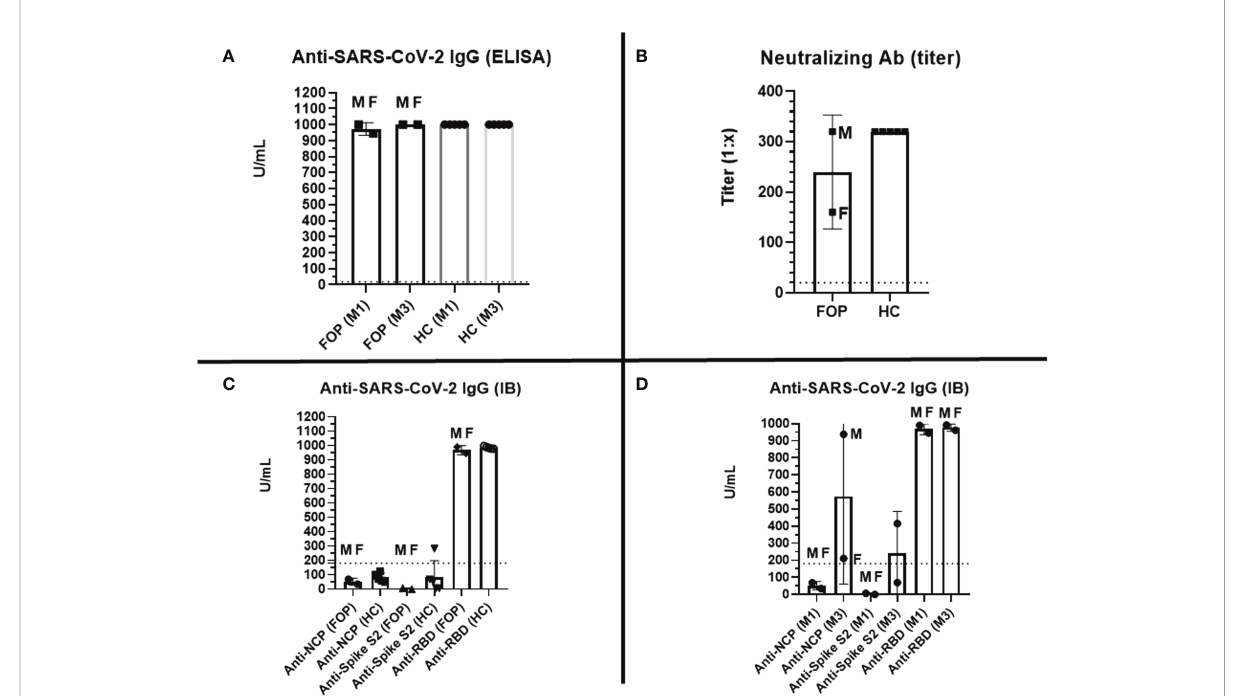
FIGURE 2 Speci fi c post-vaccination humoral response – level (U/ml, positive cut-off value > 18 U/ml, marked as dashed line) of speci fi c anti-RBD SARS- CoV-2 IgG antibodies measured by ELISA at months 1 (M1) and 3 (M3) in healthy controls (HC) and patients with Fibrodysplasia ossi fi cans progressiva (FOP, M- male patient #1, F- female patient #2) (A) ; titer (1:X) of speci fi c anti-SARS-CoV-2 neutralizing antibodies at M1 in HC and FOP (B) ; level (U/ml, positive cut-off value > 180 U/ml, marked as dashed line) of speci fi c anti- SARS-CoV-2 speci fi c IgG antibodies (spike S1; spike S2; NCP, nucleocapsid protein; RBD, receptor-binding domain) measured by immunoblot (IB) at M1 (C) , and M3 (D) in HC and